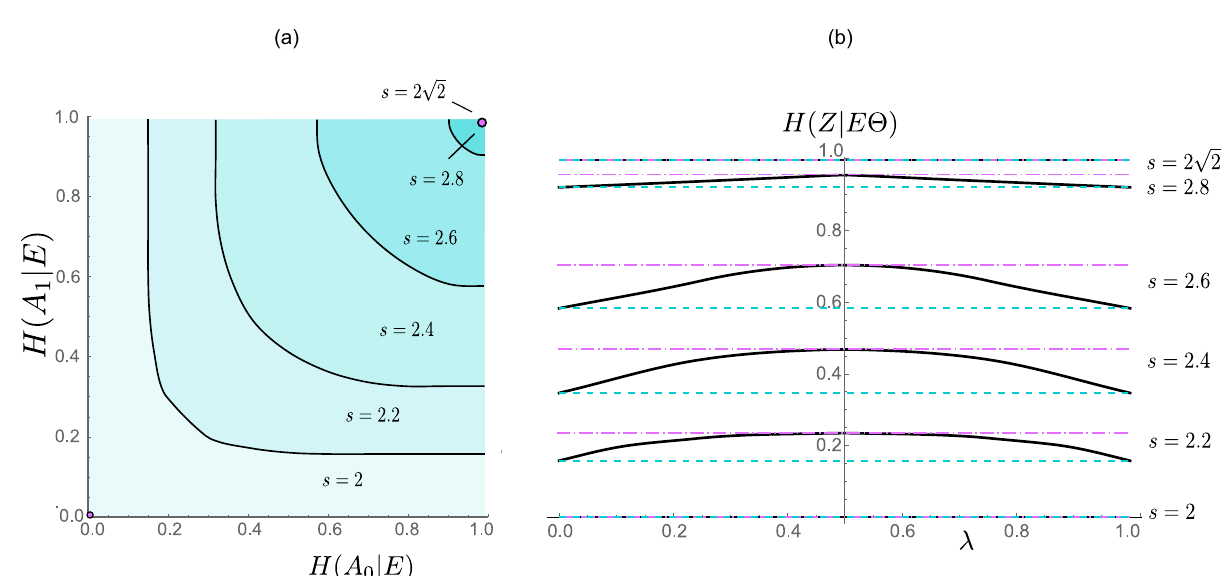
Fig. 4 Device-independent uncertainty relations. In a the plot shows the device-independent uncertainty relation between λ H ( A 0 ∣ E ) + (1 − λ ) H ( A 1 ∣ E ), where the solid line is the fundamental uncertainty C *( S ) for a given CHSH violation. The shaded region above the line hence represents the feasible region ffiffiffi p of ( H ( A 0 ∣ E ), H ( A 1 ∣ E )) given S . Evidently, when S ¼ 2 2 , we see that H ( A 0 ∣ E ) = H ( A 1 ∣ E ) = 1 must be maximally random; indeed, S ¼ 2 the case where Eve is completely uncorrelated with the devices and hence her best guess is limited to a random guess. In panel (b), the plot shows the minimal uncertainty C *( S ) (the bottom dashed line) attained when λ = 0, 1 and one can see that C * ( S ) (solid line) for 0 < λ < 1 always gives a non-trivial advantage over the limiting case (like in the original DIQKD protocol).